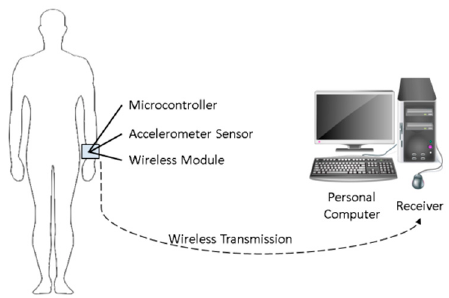
Figure 1. Schematic diagram of measurement system.